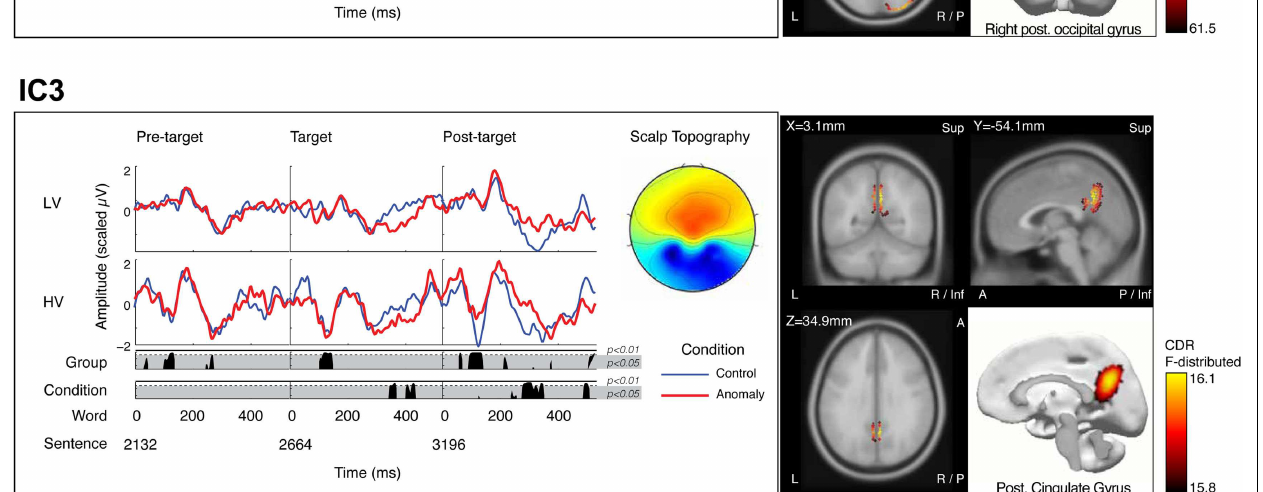
are plotted below the IC waveforms at each time point, in two rows representing pooled effects of stimulus variability (LV vs. HV; upper row) and pooled sentence-type effects (control vs. anomaly; lower row).Time points with significant differences ( p < 0.05 shown in the gray shaded region; p < 0.01 shown above the dotted line in each row) are shown by the black area plots in the corresponding row.The grand average scalp topography for the IC is plotted to the right of the time series waveforms.The right sub-panel shows the mean sLORETA solution for the IC in four views plotted against the reference MRI (MNI152): coronal, sagital, and axial planes of the MRI (X,Y, and Z, respectively) and rendered as activation in a 3-dimensional